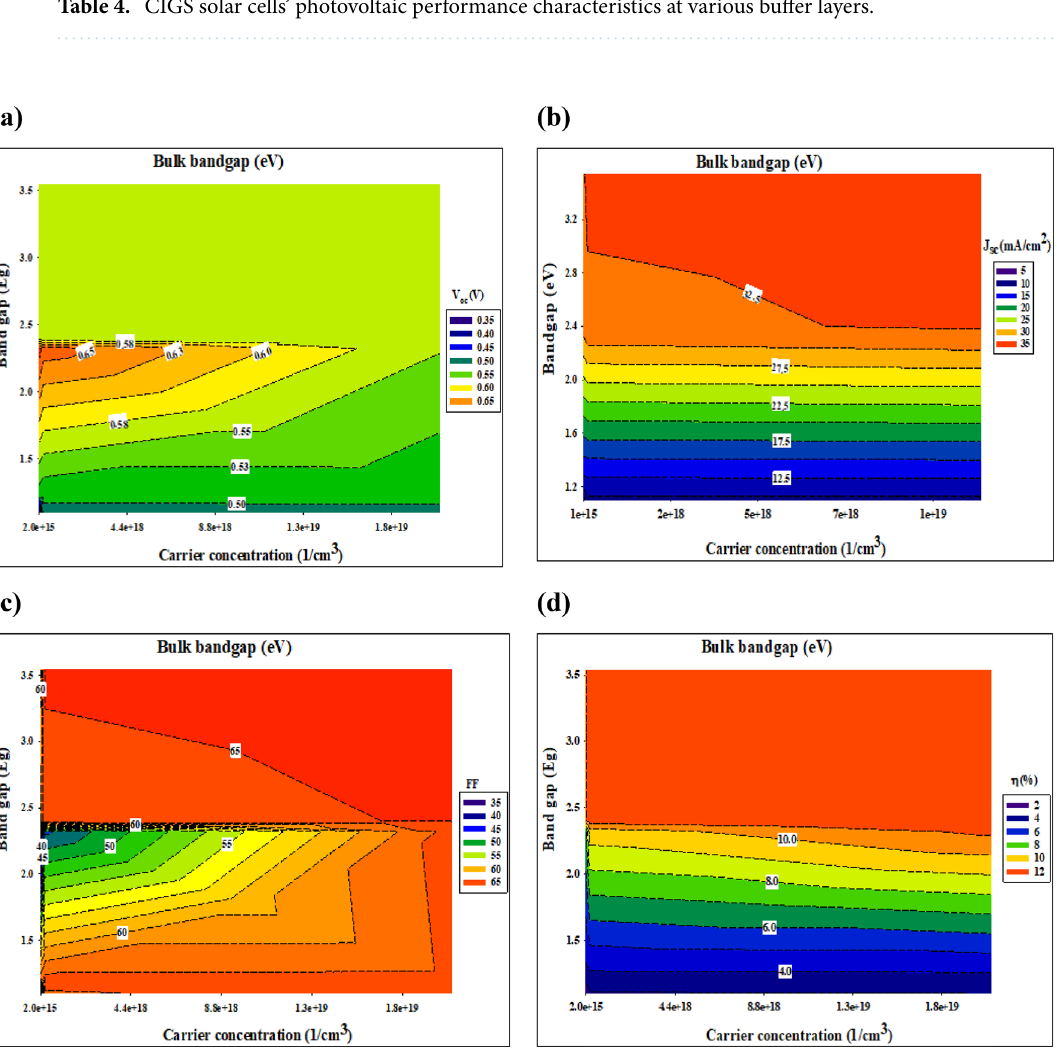
Figure 9. Photovoltaic performance parameters at bulk